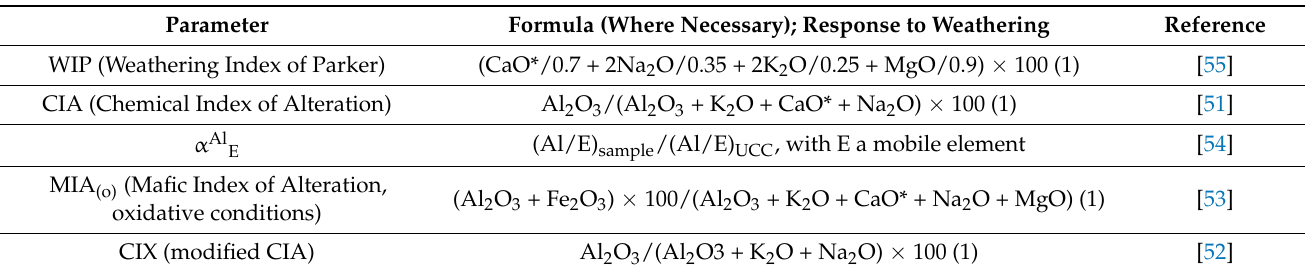
Table 3. Geochemical indices of weathering adopted in this